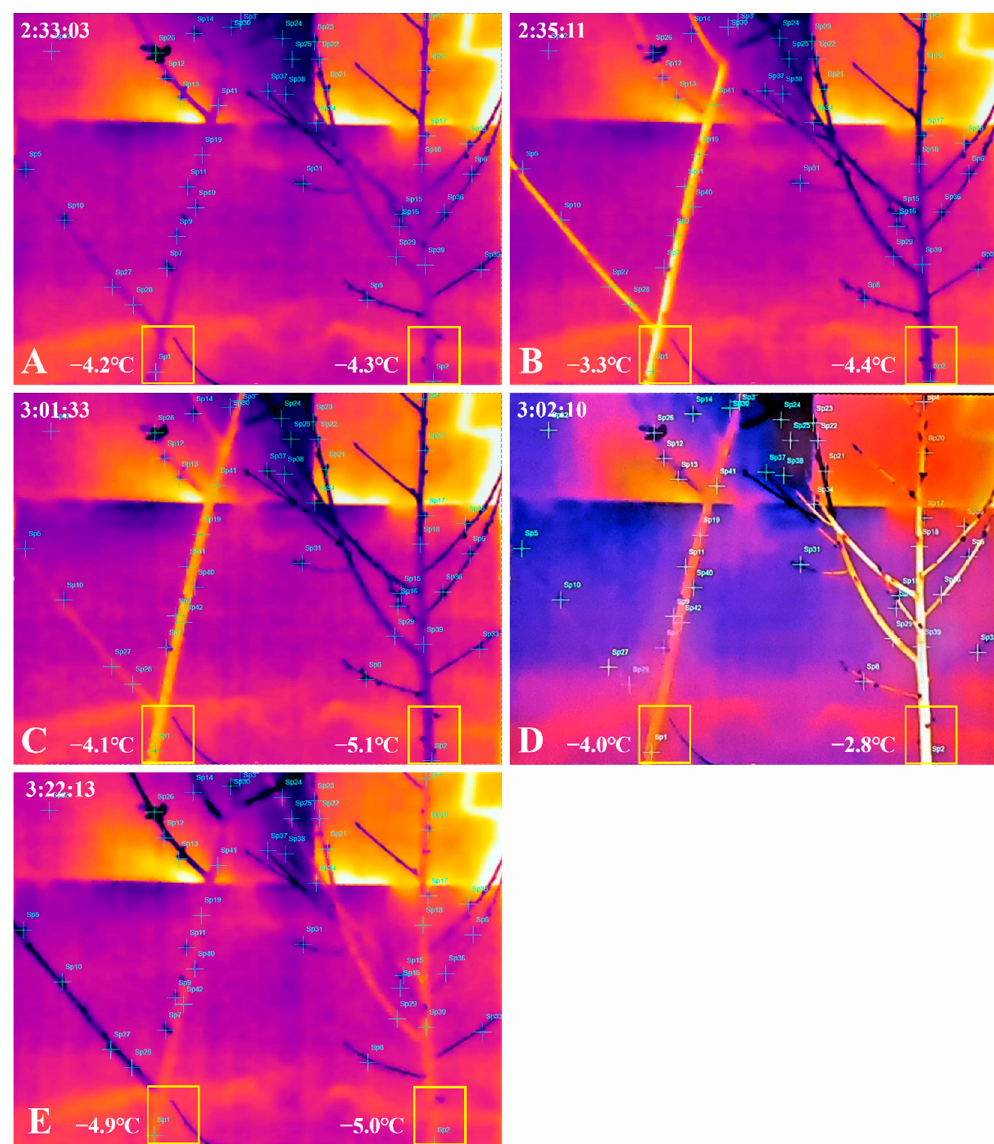
Figure 2. Visuals of the thermal changes in 2-year-old whole peach trees ( A – E ) caused by a spring frost simulation using an SFDS chamber (target temperature: − 6 °C). For the temperature and relative humidity conditions, refer to Figure 3. The control is on the left, and the 2% CNCs-treated sample is on the right. The whole plant took about 2 min to radiate heat. Exothermic behavior was observed first in the control ( A , B ). After about 30 min, the 2% CNCs-treated plant started expressing exothermic behaviors. The whole plant took about 40 s to radiate heat ( C , D ). Finally, the 2% CNCs-treated plant spent about 20 min to return to − 5.0 °C (E).